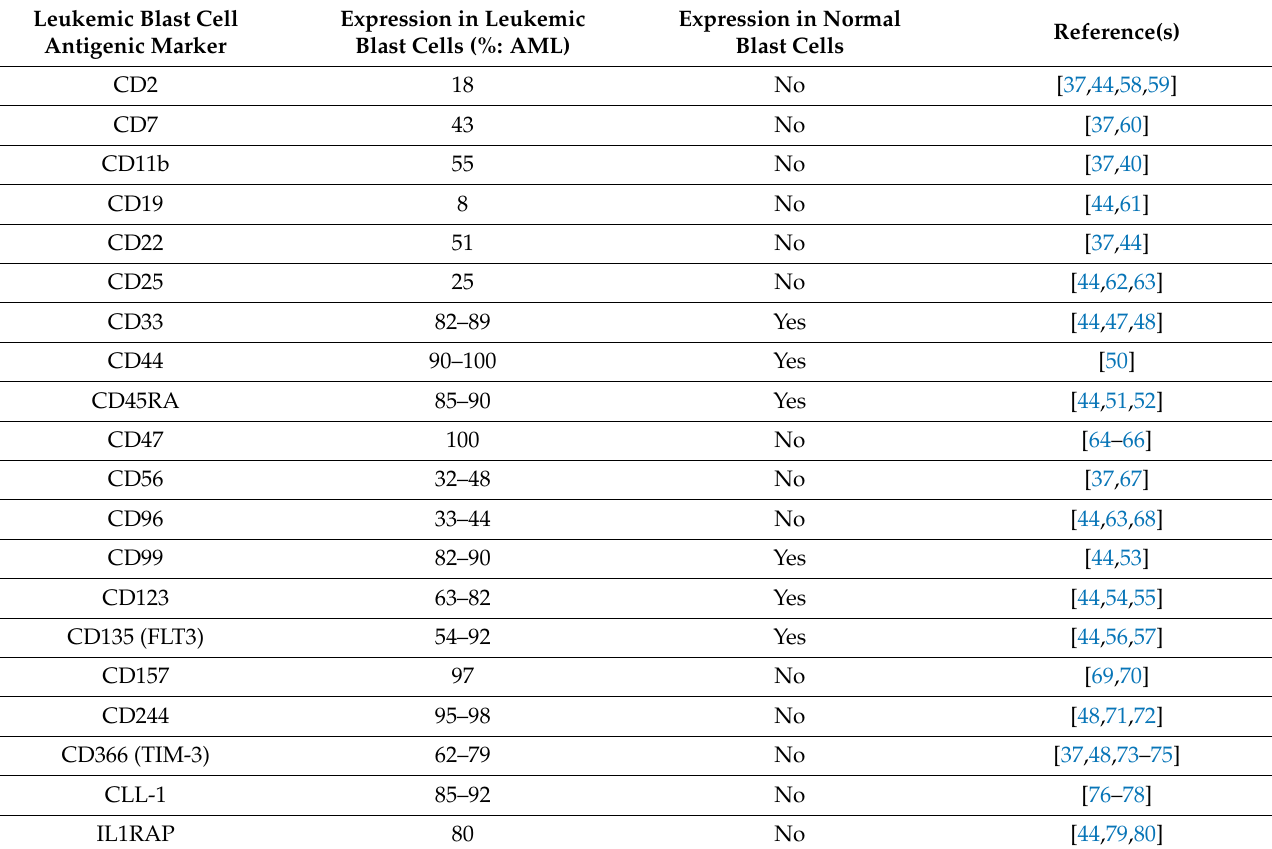
Table 2. Leukemic blast cell markers, the percentages of patients that the markers are expressed in, and expression of these markers in normal blast